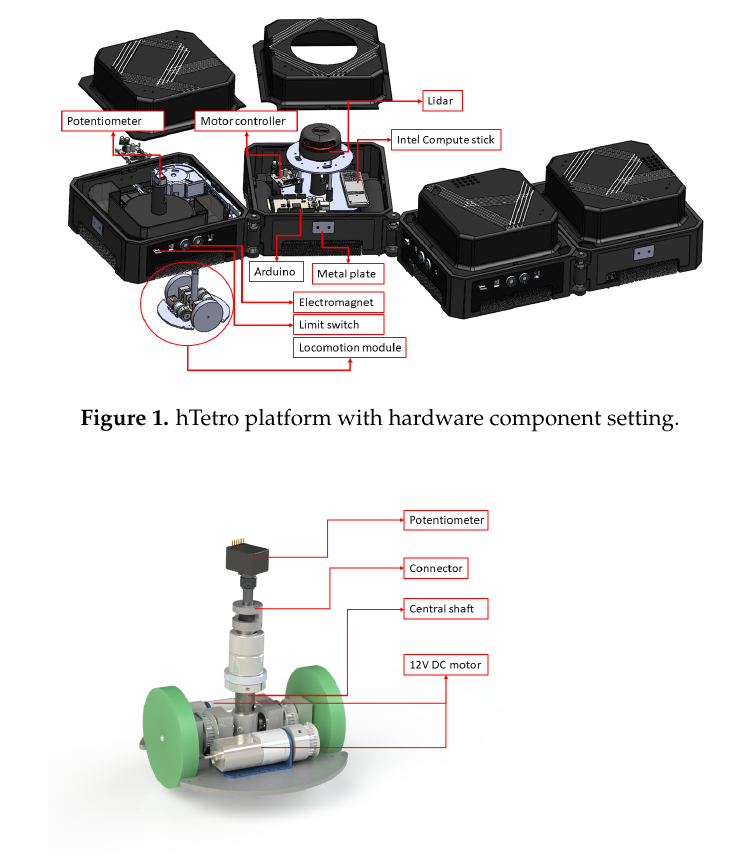
Figure 2. Differential Drive